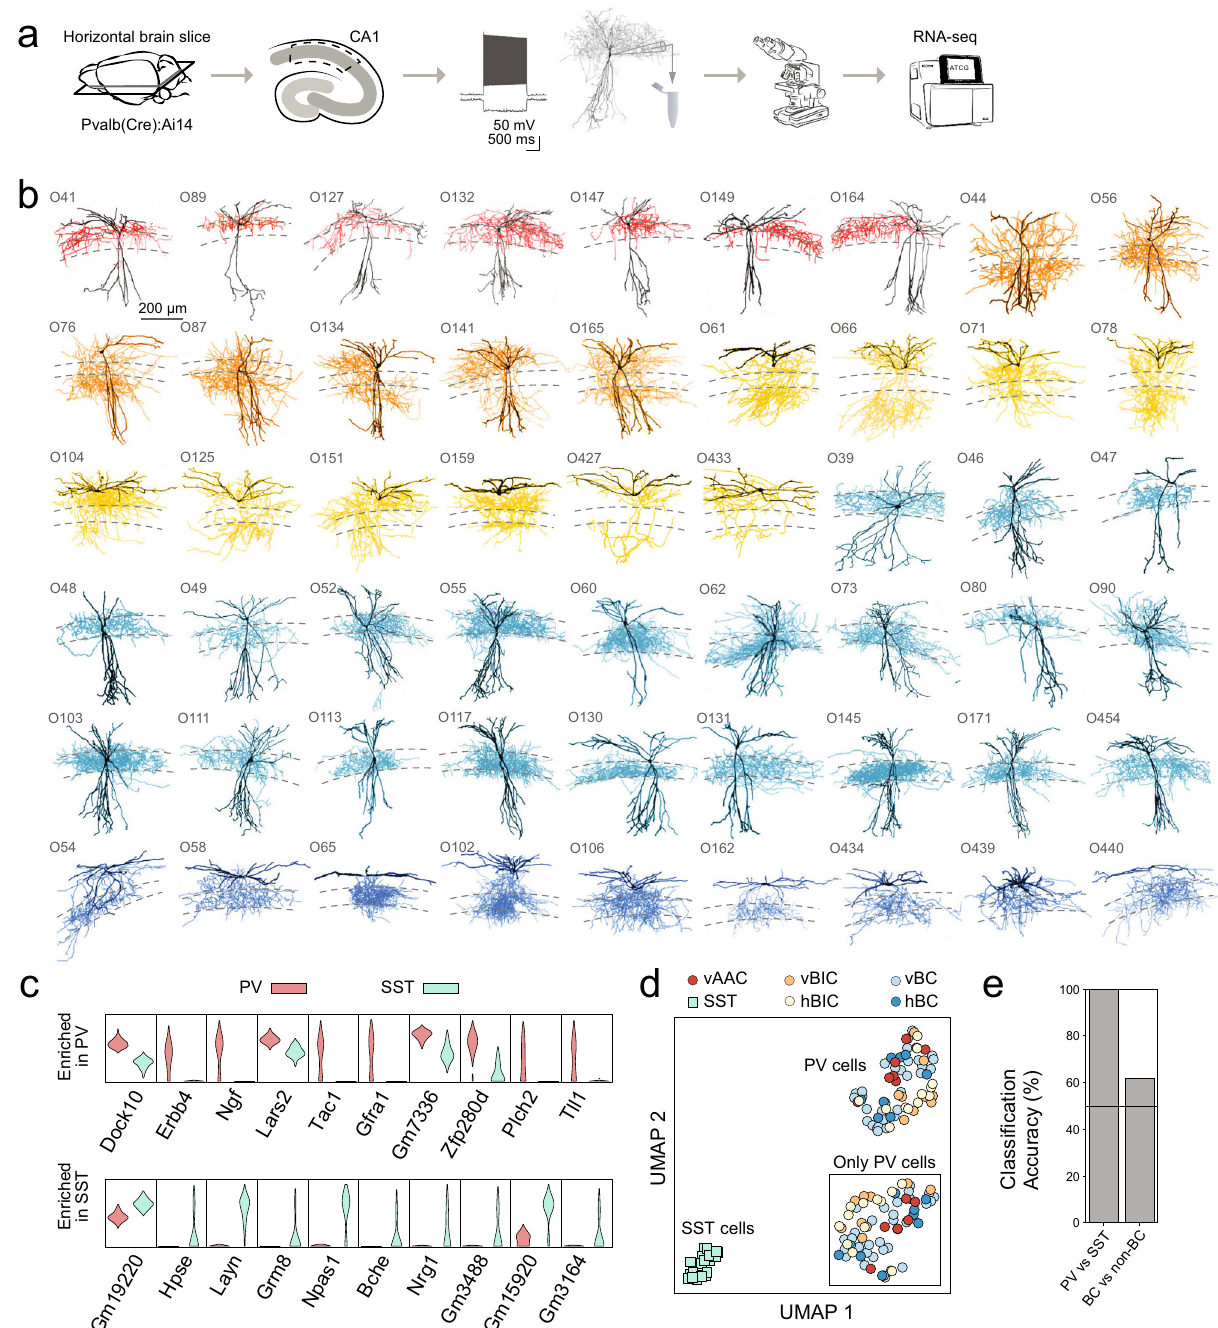
Fig. 1 Morpho-transcriptomic pro fi ling of PV-INs. a Experimental pipeline: tdTomato + PV-INs were recorded in acute brain slices, analyzed for their morphological and electrophysiological properties, and processed for single-cell RNA-seq. b Morphological reconstructions show different morphological PV types (red: vertical axo-axonic cell, vAAC, orange: vertical bistrati fi ed cell, vBIC, yellow: horizontal bistrati fi ed cell, hBIC, blue: vertical basket cell, vBC, dark blue: horizontal basket cell, hBC; these color code applies to all fi gures). c Violin plots show expression of top ten genes that are enriched in PV versus SST-OLM (upper plots) and in SST-OLM versus PV cells (lower plots). d Plot shows transcriptomic data-based dimension reduction using UMAP. Symbols correspond to different PV and the SST-OLM types. Insert shows UMAP for only PV-INs. e Bar plot shows classi fi cation accuracy for random-forest-based PV versus SST-OLM, BIC versus non-BIC, and for BC versus non-BC discriminations. suf fi cient to de fi ne separate training and testing sets) for (Fig. 1d; also see Supplementary Fig. S3). By comparison, a distinguishing morphological PV types (Fig. 1e). supervised (random forest) classi fi cation algorithm accurately classi fi ed cells as PV or SST type (99.9% accuracy) but proved to be less ef fi cient at (78.4% accuracy in case of the BIC versus non- BIC comparison) or insuf fi cient (61.4% accuracy in case of the BC versus non-BC comparison, where sample numbers were NATURE COMMUNICATIONS| (2021) 12:108